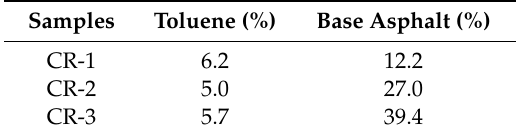
Table 3. Results of the dissolving rate in Toluene and base